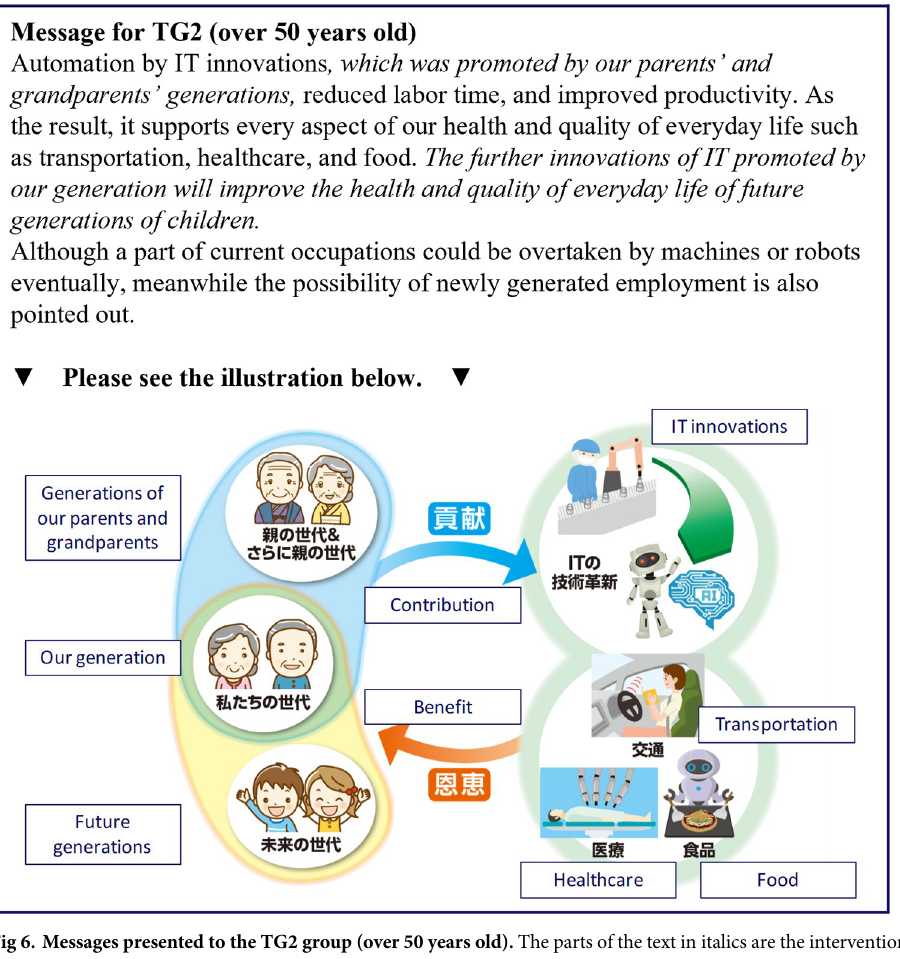
Fig 6. Messages presented to the TG2 group (over 50 years old). The parts of the text in italics are the intervention messages.